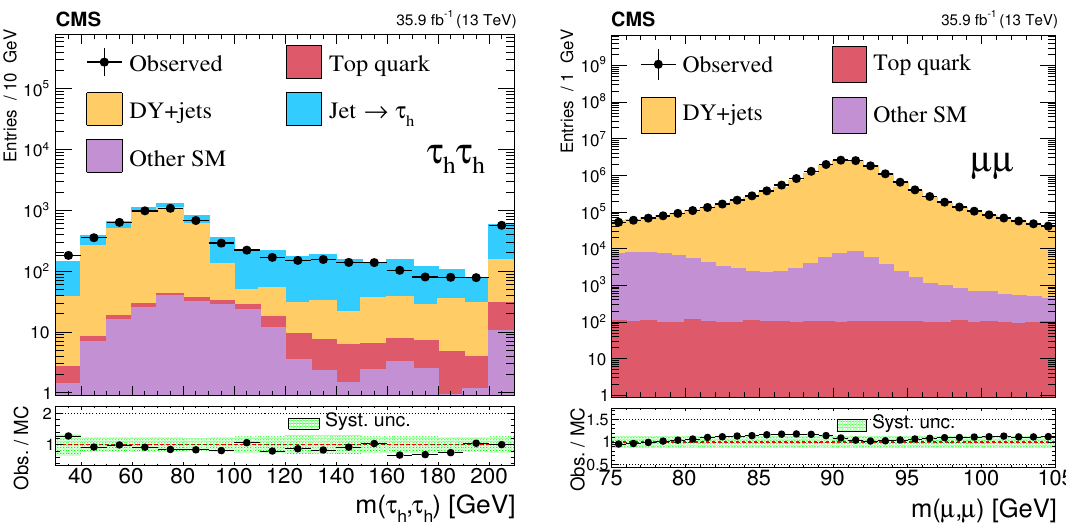
Figure 2. Left: visible mass spectrum used to validate the modeling of the DY+jets background in the (cid:28) h (cid:28) h (cid:12)nal state in a Z ! (cid:28)(cid:28) control sample selected with low m T2 or (cid:6) m T and a minimum (cid:28) h (cid:28) h system p T of 50 GeV. The last bin includes over(cid:13)ows. Right: dimuon mass distribution in the high-purity Z ! (cid:22)(cid:22) control sample after all estimated correction factors have been applied to the simulation. In the legend, \Top quark" refers to the background originating from tt and single top quark